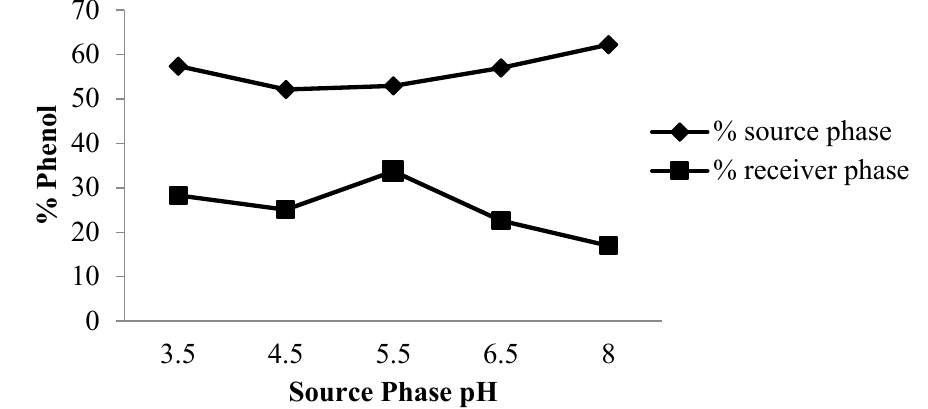
Figure 2. Curve effect of source phase pH on phenol levels.